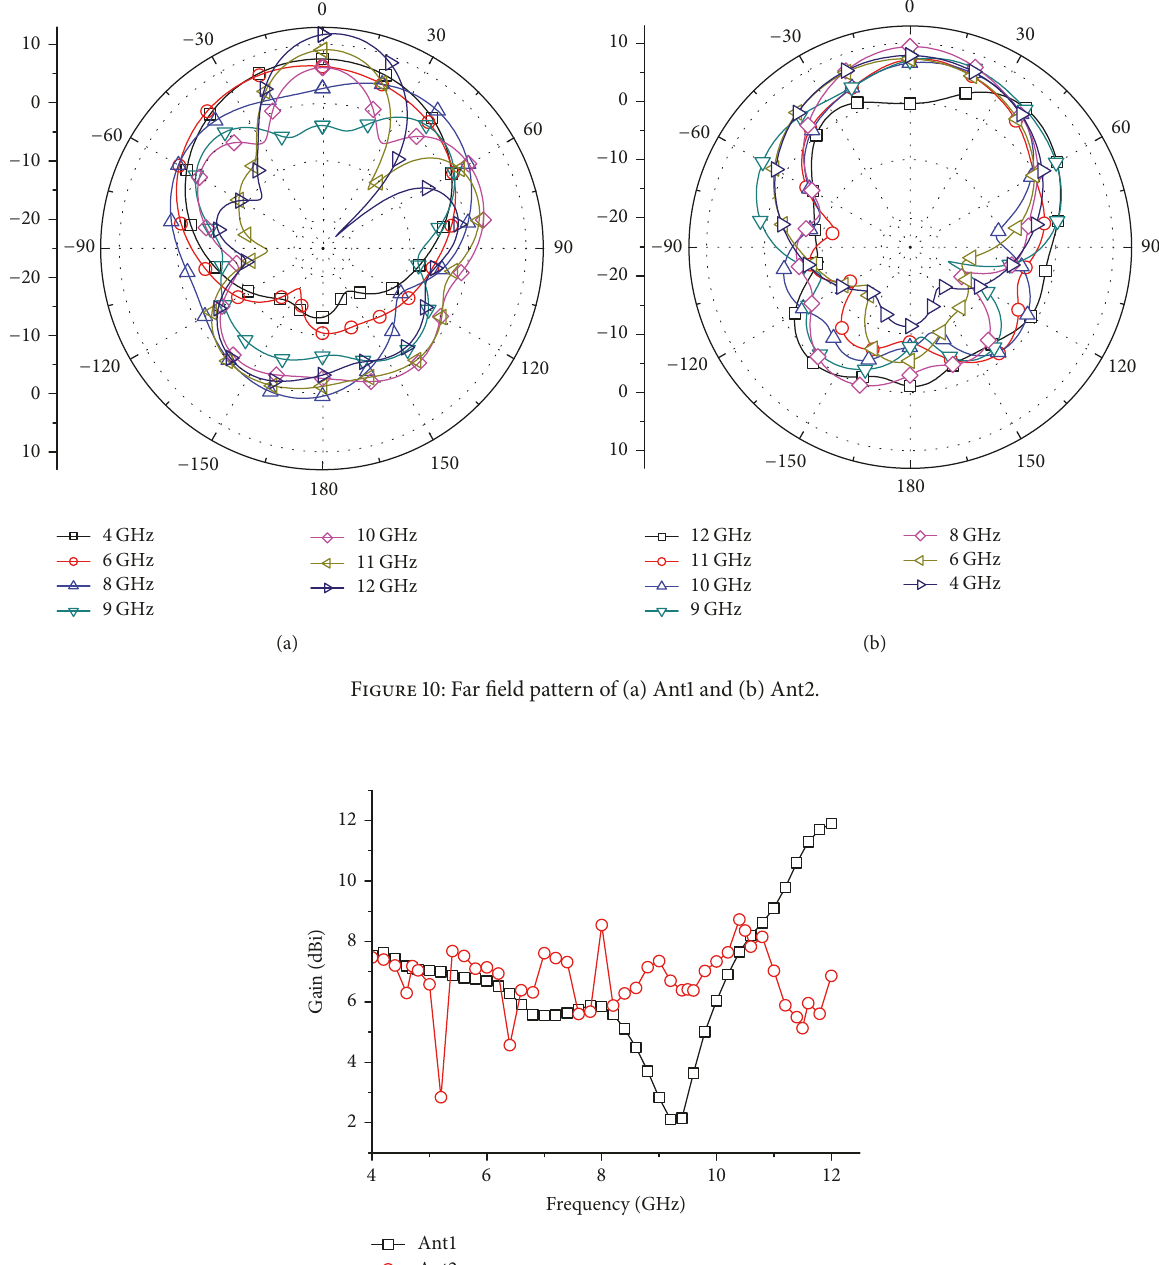
Figure 11: Simulated gain of Ant1 and